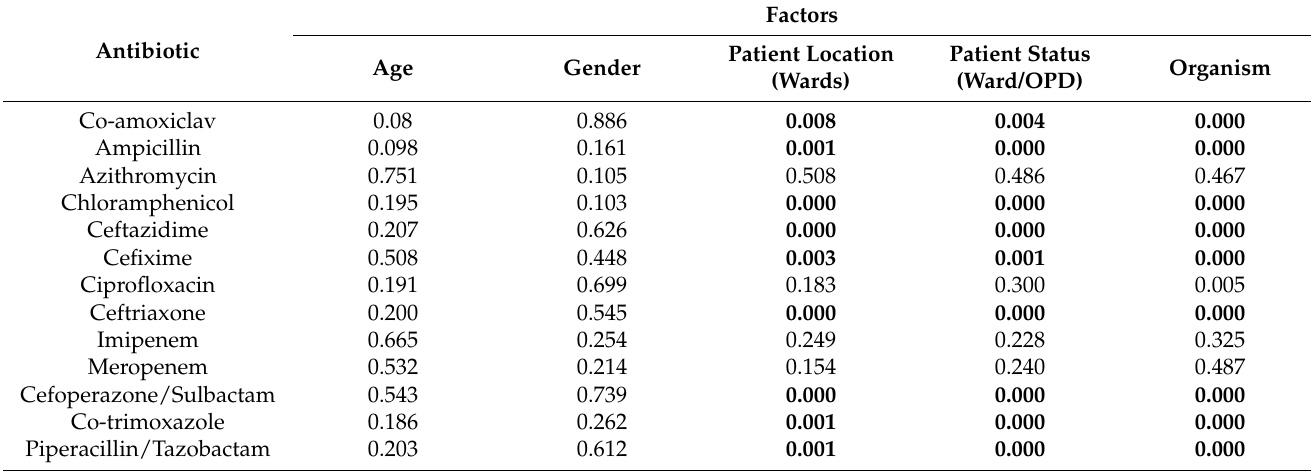
Table 1. The impact of gender, age, patient location (type of hospital ward), patient status (hospitalized or outdoor), and the type of Salmonella strains on the occurrence of antibiotic resistance was evaluated. The statistical analysis was performed by applying the Mann–Whitney U test (for patient gender and hospitalization status) and the Kruskal–Wallis H test (for age, patients’ ward, and pathogen).